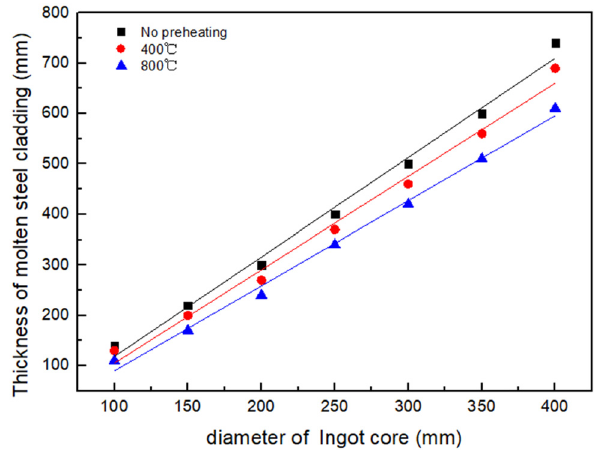
Figure 8: Thickness of the cladding layer varies with the diameter of the ingot core.